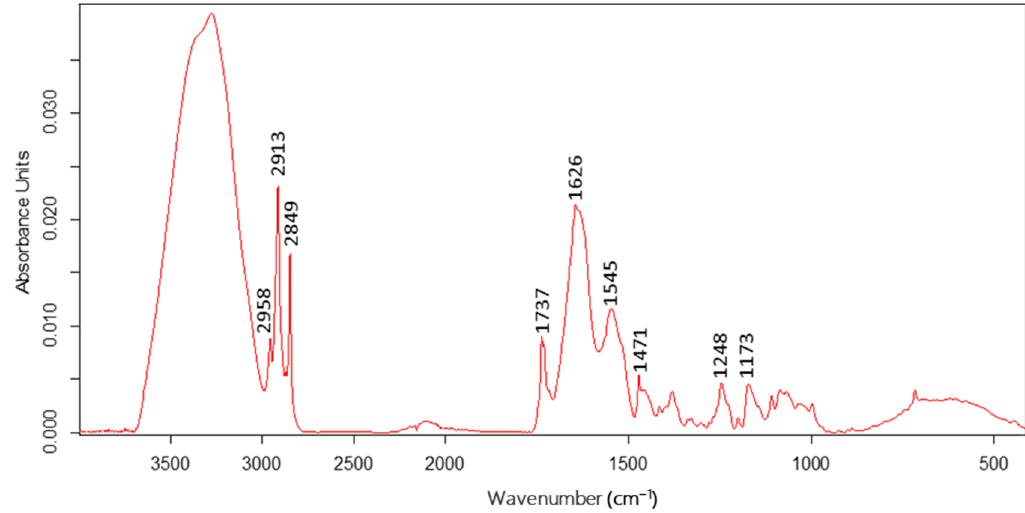
Figure 1. Averaged ATR-FTIR spectrum of aphid species.